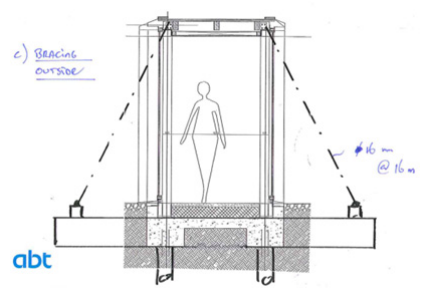
Fig. 9 Bracings placed